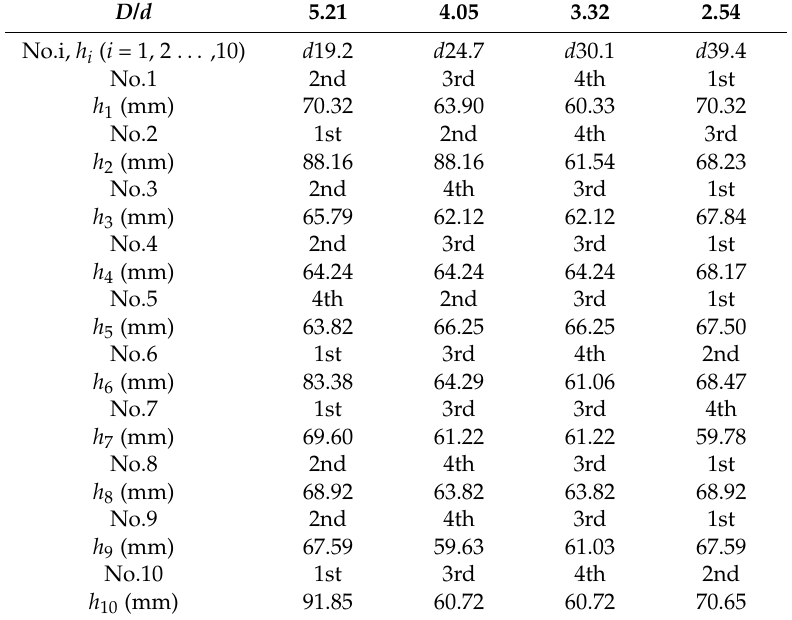
Table 8. Results of multiple particle